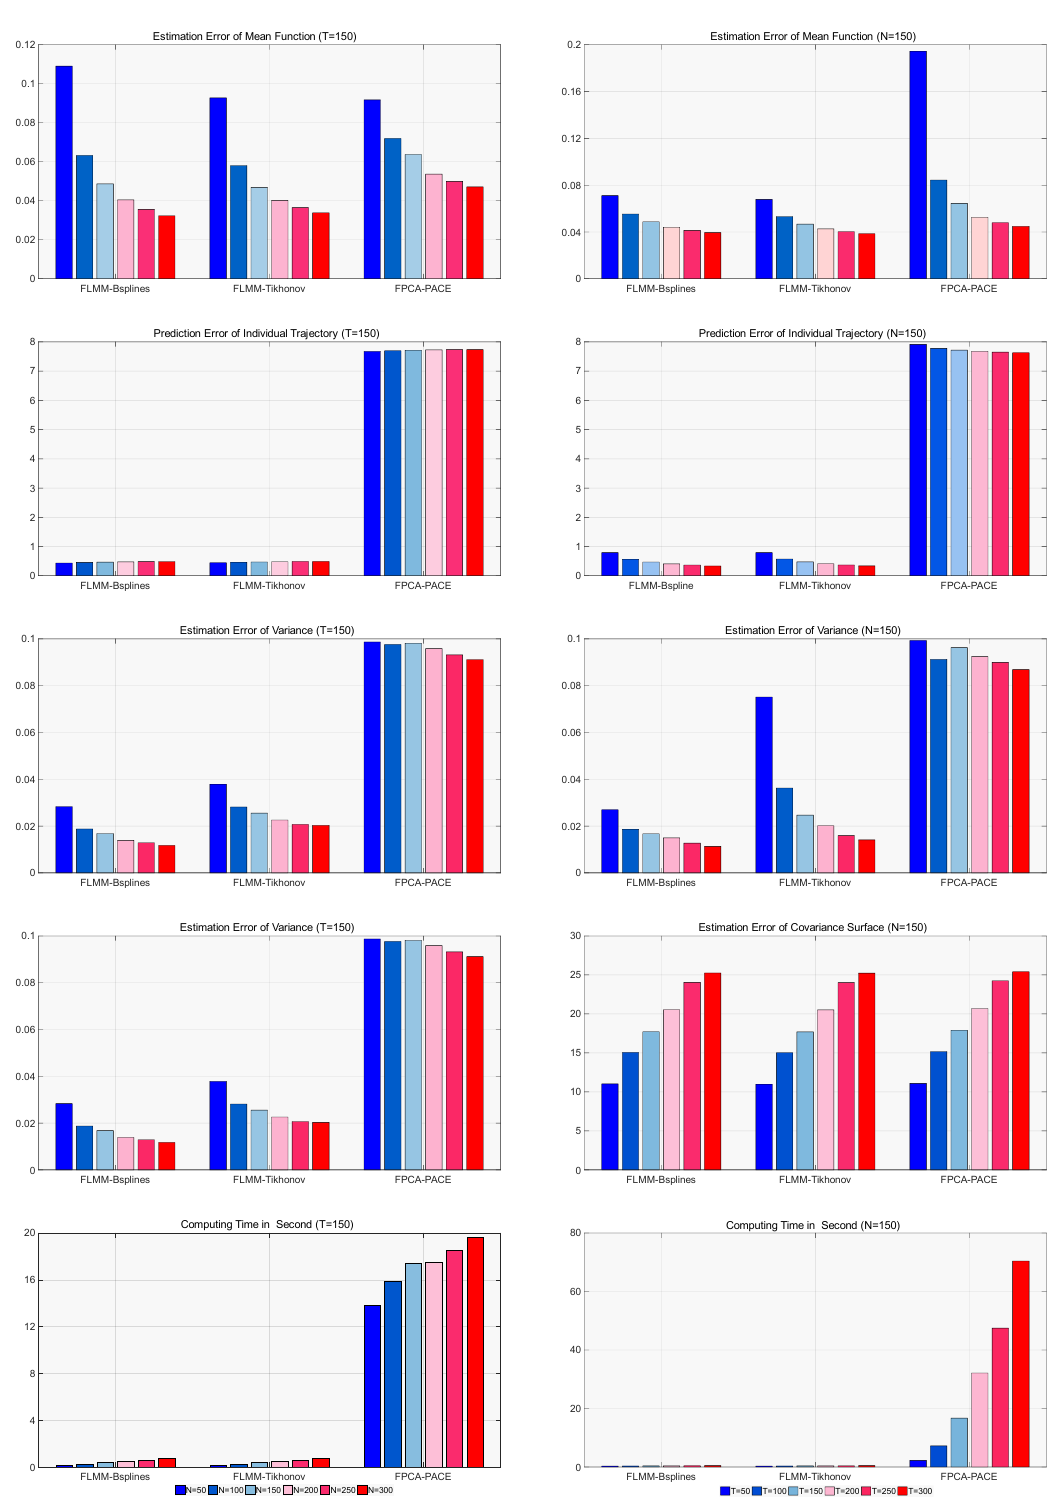
Figure 3. Estimation errors of mean function, individual trajectory, variance, covariance surface, and running time in the three